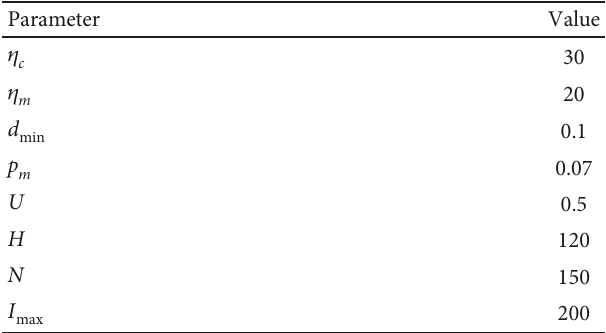
Table 13: Parameters of I-NSGA-III algorithm (Part).